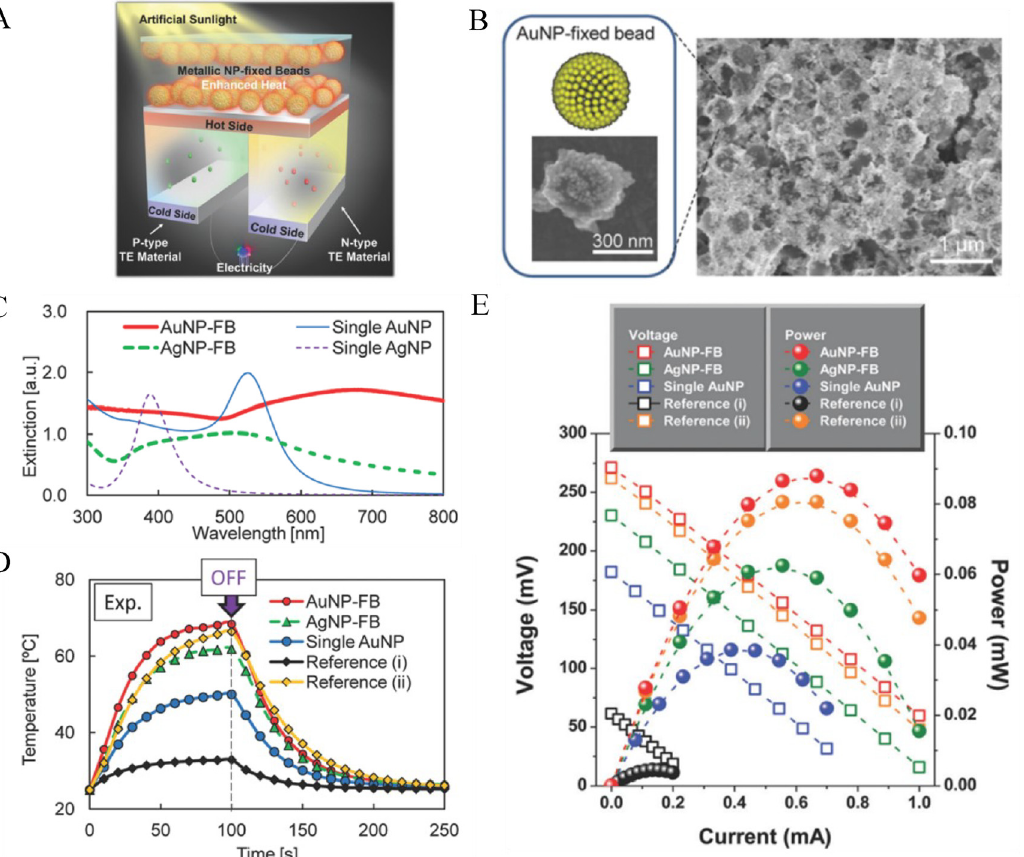
Figure 13: (A) Schematic representation of the solar thermoelectric device based on plasmonic Au nanoparticle-fixed beads (Au NP-FB). (B)SEMimagesofAuNP-FBfilm.(C)MeasuredextinctionspectraofAuNP-FBfilm,AgNP-FBfilm,singleAuNP,andsingleAgNP.(D)Correlation between temperature and time of the Au NP-FB, Ag NP-FB film, and single Au NP under illumination of sunlight and after turning the light off. (E) Power generation properties of the solar thermoelectric device based on plasmonic nanostructures after 5 min under artificial sunlight irradiance [56]. Copyright 2015, Royal Society of